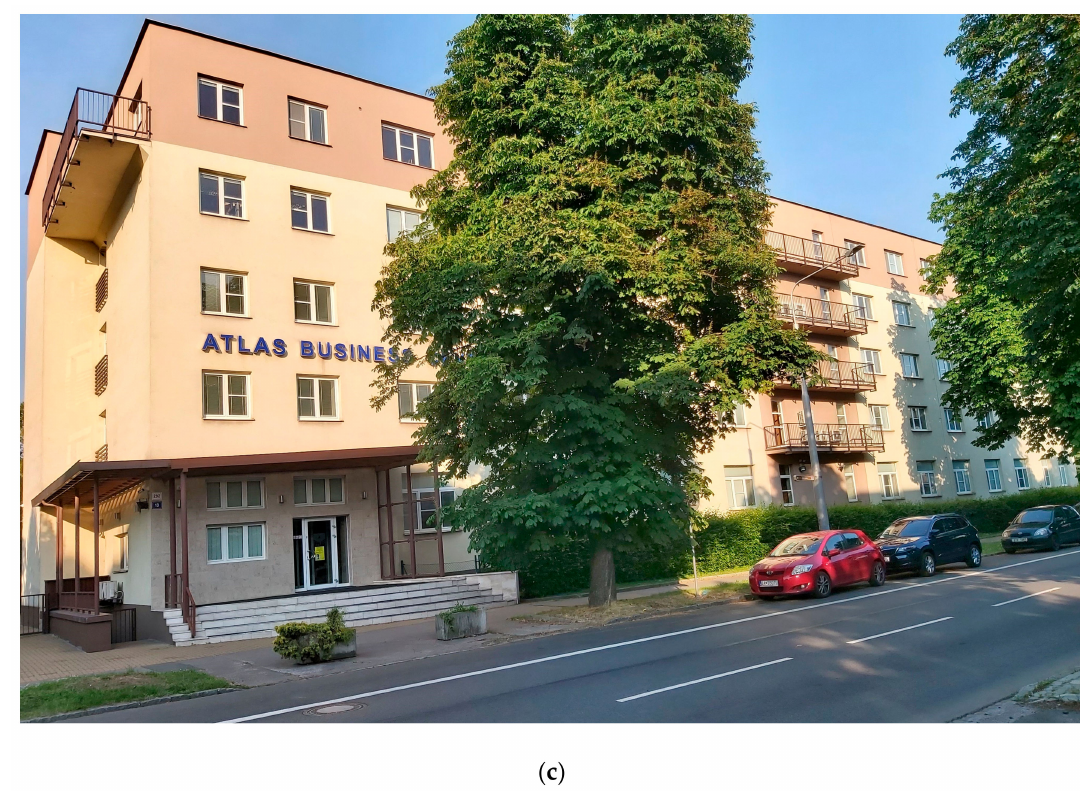
Figure 9. Selected buildings in the Hub E: ( a ) location E1, ( b ) location E2, and ( c ) location E3.